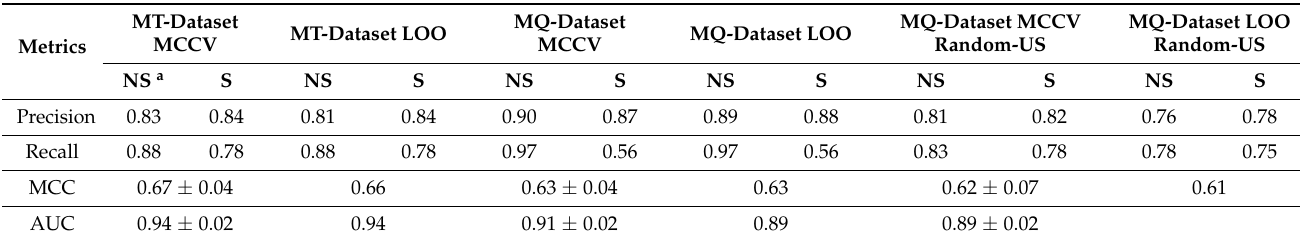
Table 2. Performances of the six developed predictive models for the two considered datasets. Both the entire MT- and MQ-datasets were used to obtain models by the MCCV, and the LOO validation runs. Due to its unbalanced nature, the MQ-dataset was also utilized to generate models by the MCCV and the LOO validation runs after random undersampling (US). For MCCV models and for MCC and AUC metrics, standard deviations are also